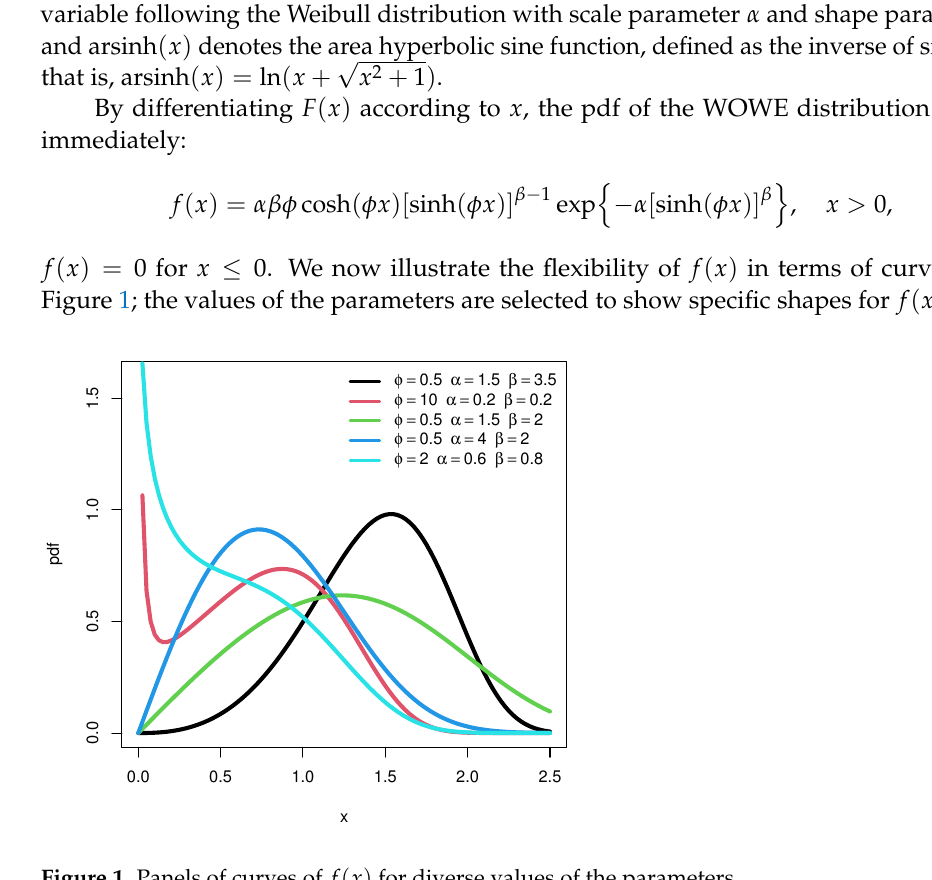
a decreasing function with small variations; the navy blue curve shows a right-skewed function; the green curve refers to an almost symmetric function; the black curve represents a left-skewed function; and finally, the red curve presents a perfect reversed N